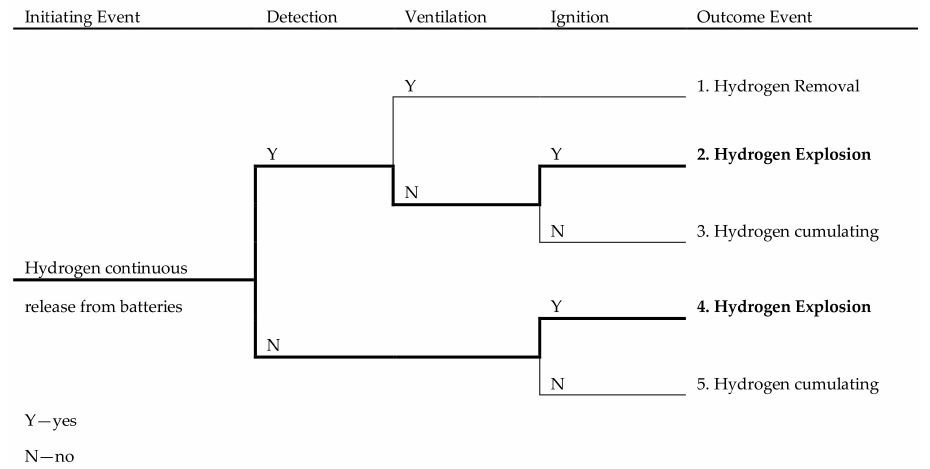
Figure 1. Event tree used for the derivation of possible incident scenarios.